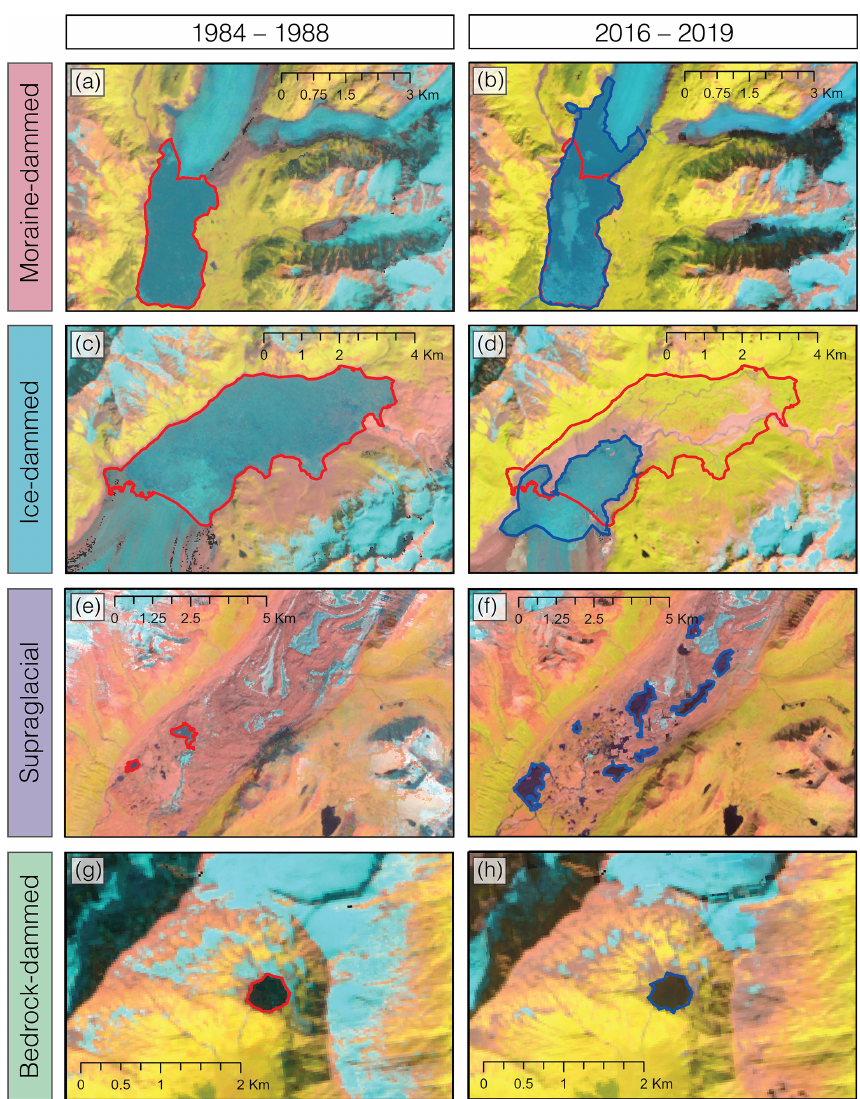
Figure 3. Examples of typical lake behavior for each dam type – moraine (a, b) , ice (c, d) , supraglacial (e, f) , and bedrock (g, h) – and changes in lake area from 1984–1988 ( a, c, e, g ; red) and 2016–2019 ( b, d, f, h ; blue). False color images using Landsat bands for shortwave infrared (SWIR), near infrared (NIR), and